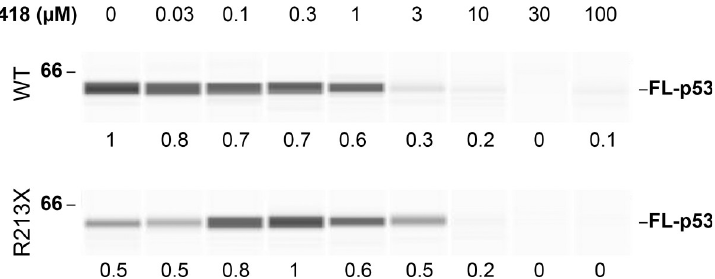
Fig 1. PTC readthrough in a cell-free translation assay. WT and R213X TP53 mRNAs were translated in vitro in the presence of G418 at the indicated concentrations and equal amounts of protein were subjected to automated capillary electrophoresis western analysis. The data are displayed as “pseudo-blots” of bound p53 antibody chemiluminescence. FL-p53 chemiluminescence is expressed relative to the maximum value observed in either WT or R213X and shown under each lane. Uncropped images of automated capillary electrophoresis western analyses are provided in S1 Raw Images. FL AU : AbbreviationlistshavebeencompiledforthoseusedinFigs 1 ; 2 ; and 5 (cid:0) 7 : Pleaseverifythatallentriesarecorrect : -p53, full-length p53; PTC, premature termination codon; WT, wild-type.